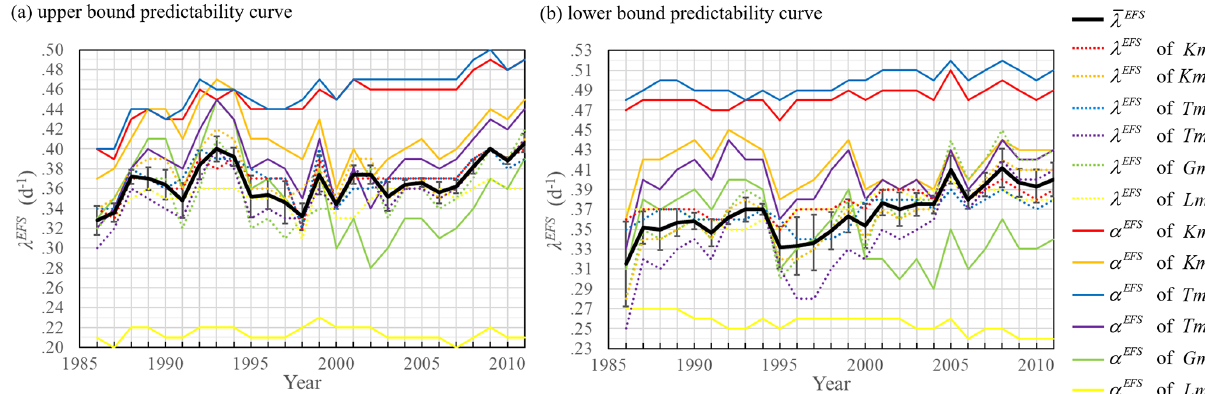
Figure 5. Lyapunov exponents λ EFS of the ECMWF forecasting system calculated by Eq. (14) and parameters α EFS of error growth models for (a) upper- and (b) lower-bound predictability curves. λ EFS is the average value over all error growth models.